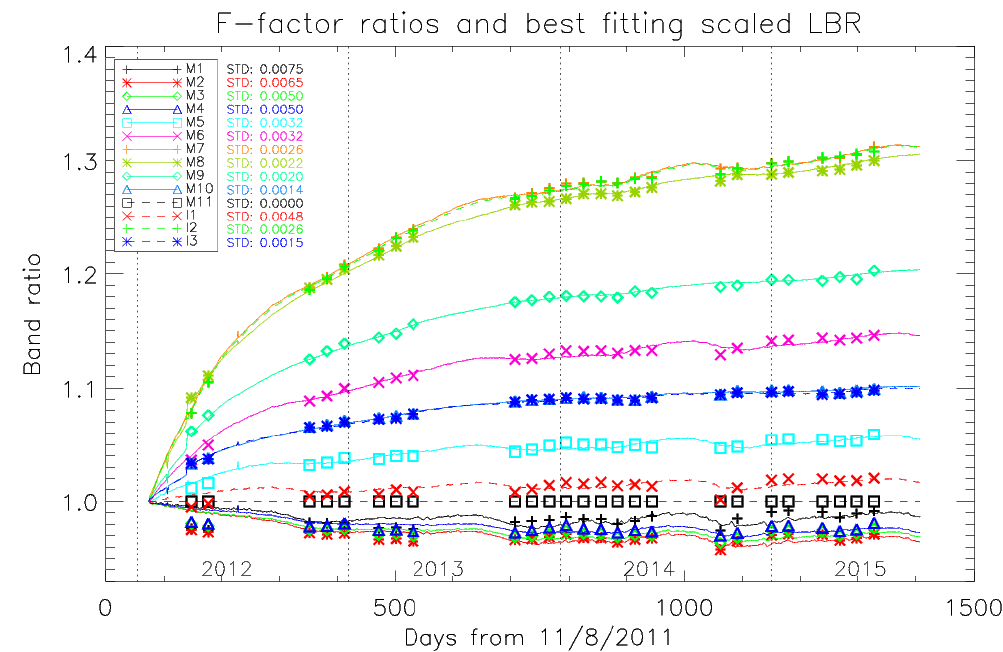
Figure 10. F-factor ratios and lunar LBRs for all VIIRS RSBs. The SD based F-factors and LBR are both normalized to reference band M11. Table 2. Percent standard deviation improvements when comparing MT model-based lunar F-factor to LBR approaches. Both use SD-F factor as reference in calculating standard deviations.